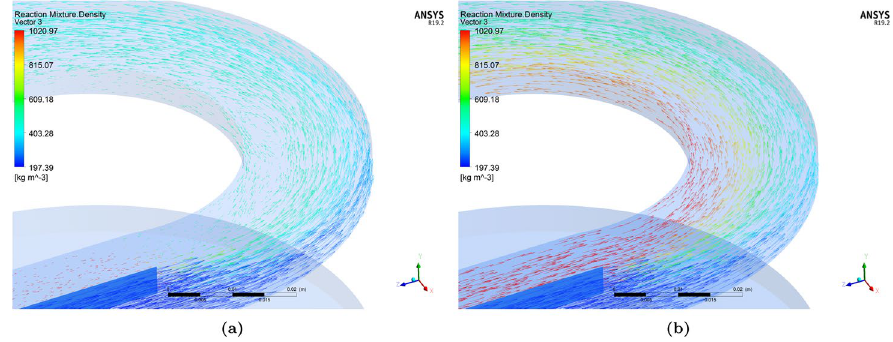
Figure 5. Velocity vector plot for FS1: ( a ) FR = 0.25 , and ( b ) FR = 1.5 . Images used courtesy of ANSYS,